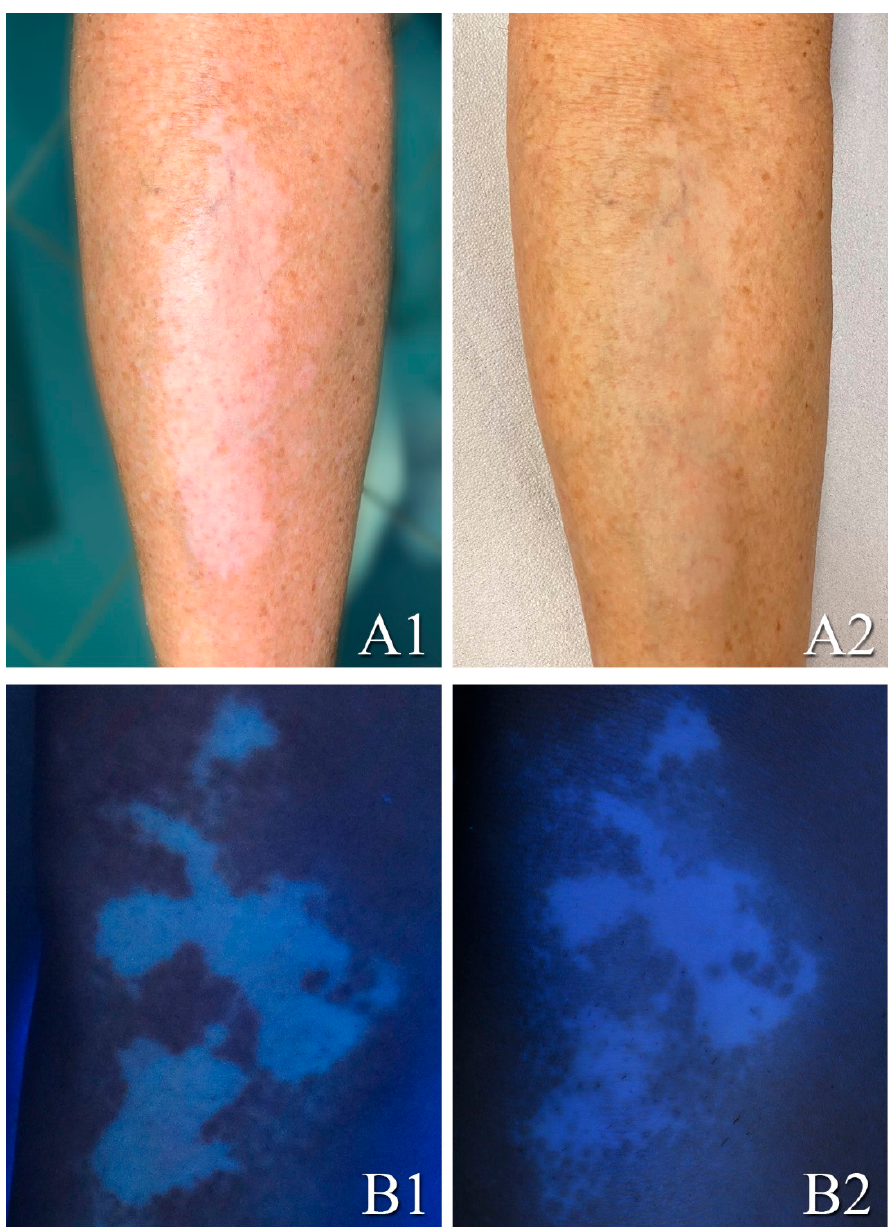
Figure 3. Examples of vitiligo lesion before and after full treatment in two different patients after a follow-up of 10 months, under a standard light lamp ( A1 , A2 ) and under a UV lamp ( B1 , B2 ): vitiligo lesion in the tibia area ( A1 ) improved following moderate uniform re-pigmentation ( A2 ); vitiligo lesion in the knee area ( B1 ) improved following a point re-pigmentation ( B2 ). Table 1. Clinical features.